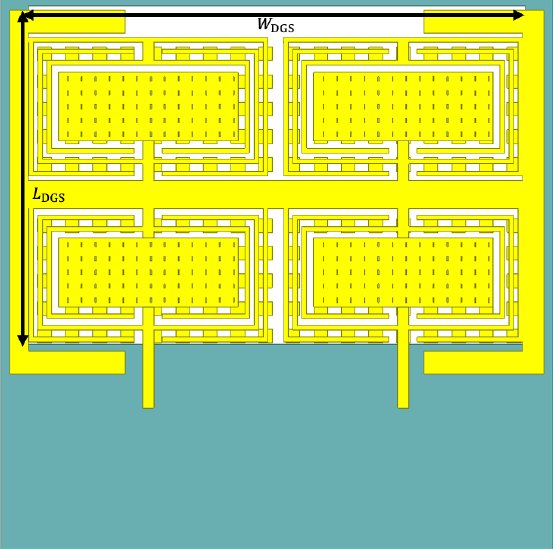
Figure 14. Add DGS and hollow out the metal at the bottom. (The parameters are: 𝐿 𝐷𝐺𝑆 = 735 μm , and 𝑊 𝐷𝐺𝑆 = 1080 μm .)